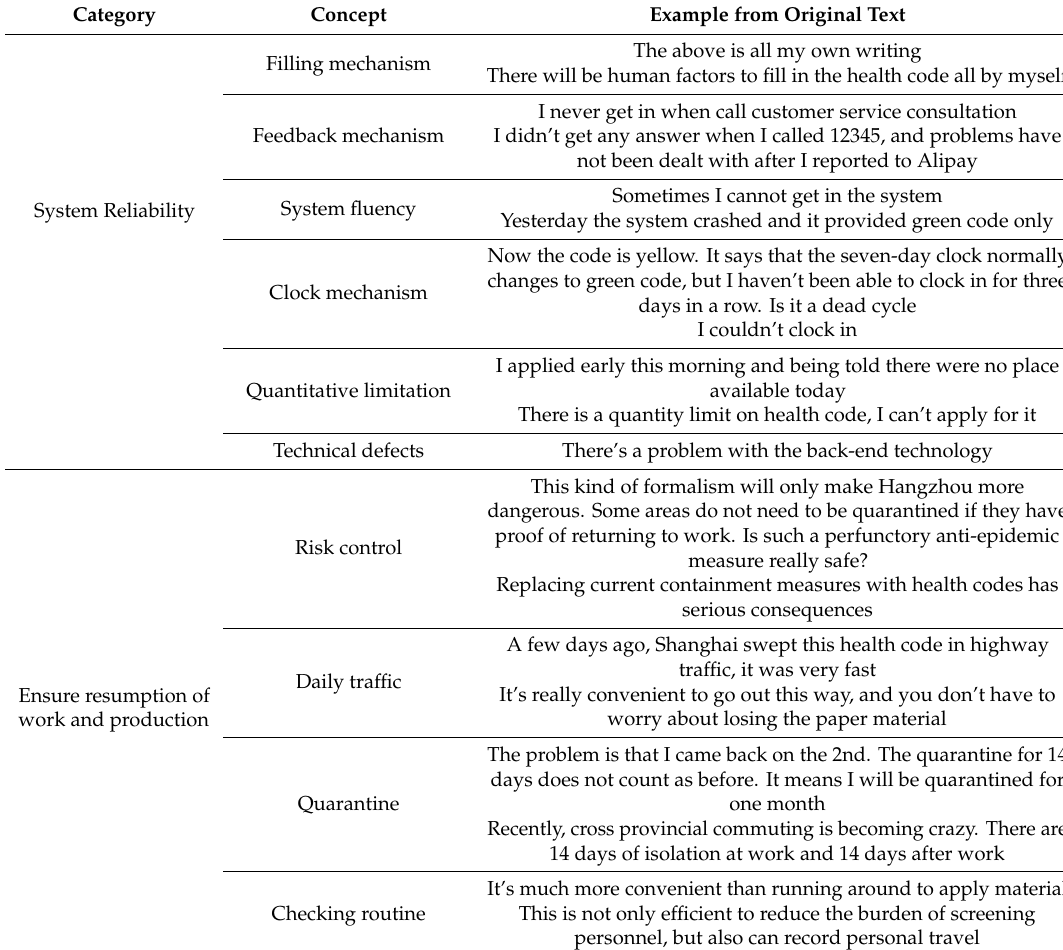
Table 1. Examples of open